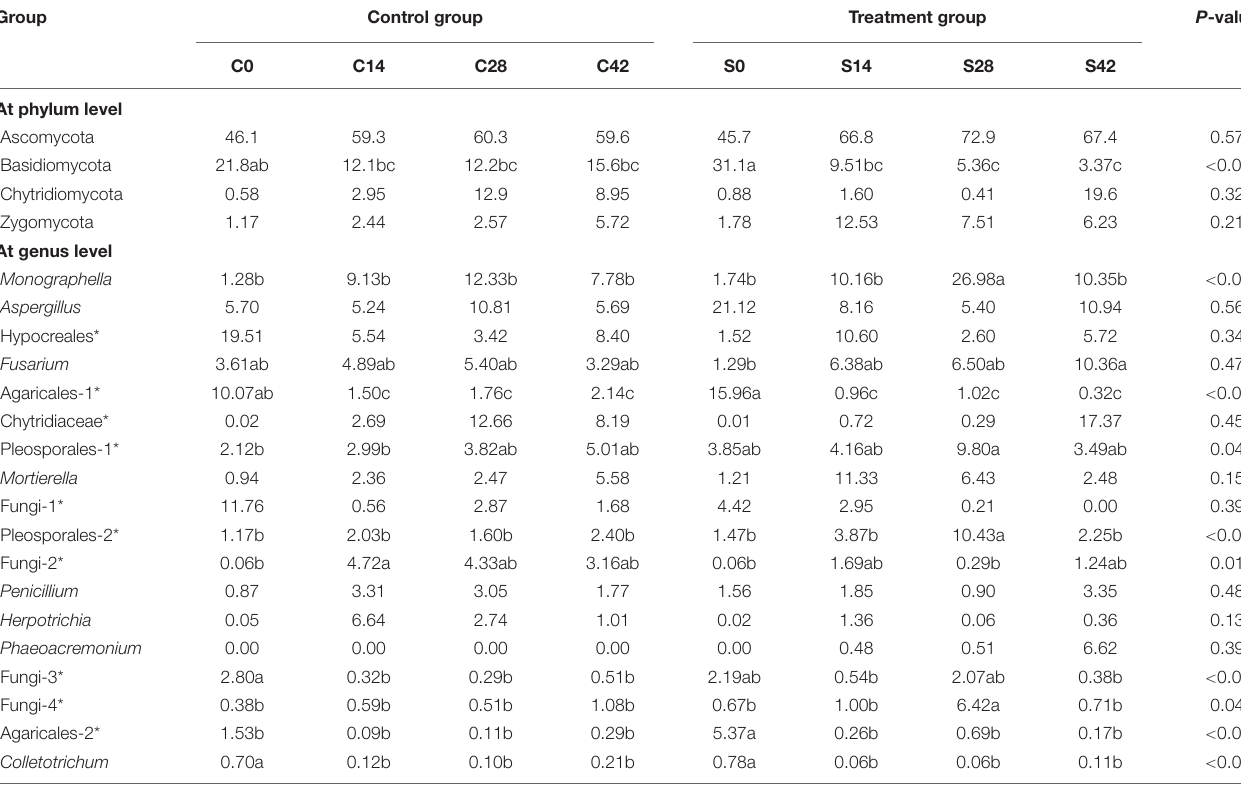
TABLE 4 | Main fungal groups or the group with significant difference (%). Group Control group Treatment